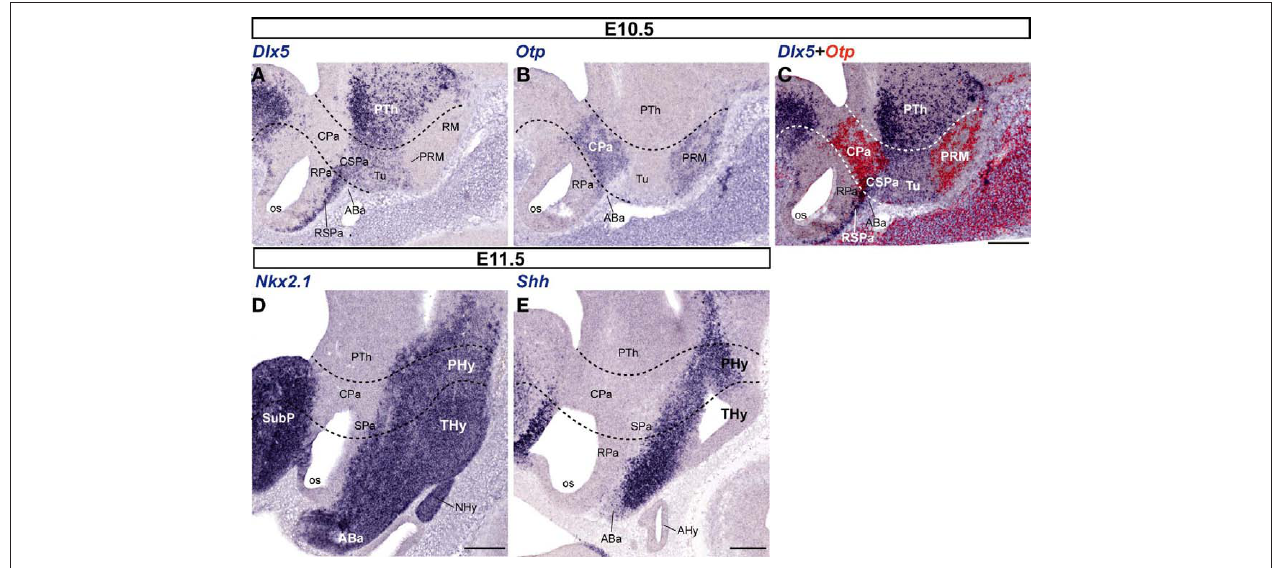
FIGure 2 | representative sagittal sections from e10.5 (A–C) and e11.5 (D,e) embryos, showing the expression domains of Dlx5 (A), Otp (B), Dlx5 + Otp (C; digital overlap with pseudocolor of A,B), nkx2.1 (D), and shh (e). The transversal boundaries of the PHy and THy are indicated by dashed lines. Bars = 200